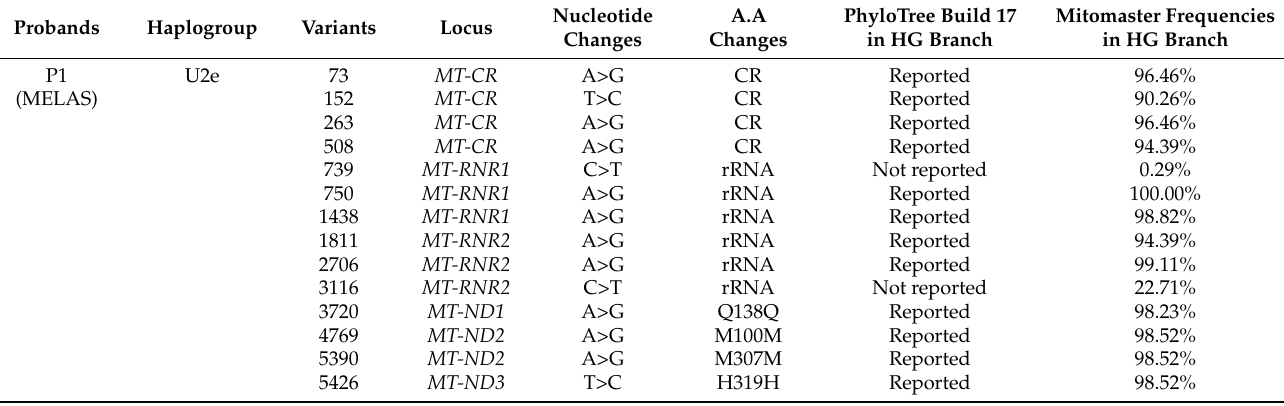
Table 2. Polymorphic mtDNA variants detected in Serbian probands with mitochondrial encephalomyopathies. Probands